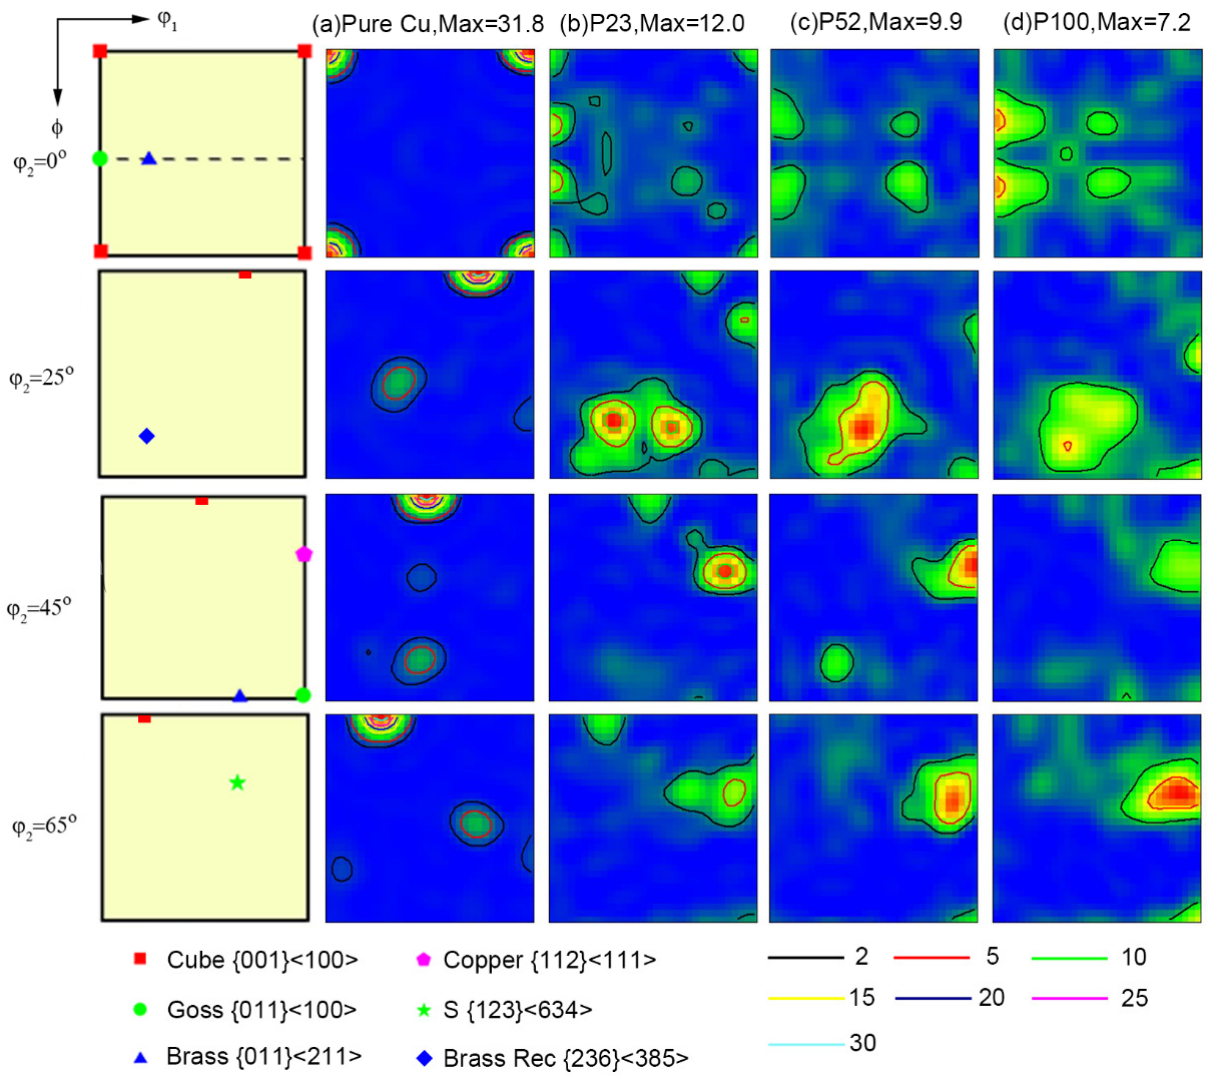
Figure 7. ODF sections of φ 2 = 0°, φ 2 = 25°, φ 2 = 45° and φ 2 = 65° of the final cold rolled Cu